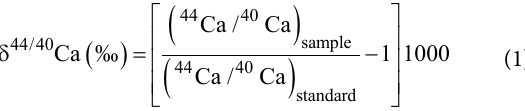
Supplementary Table S1 . For several elements, it is conventional that only the heavier isotope is included in the δ notation (e.g., δ 44/40 Ca is written as δ 44